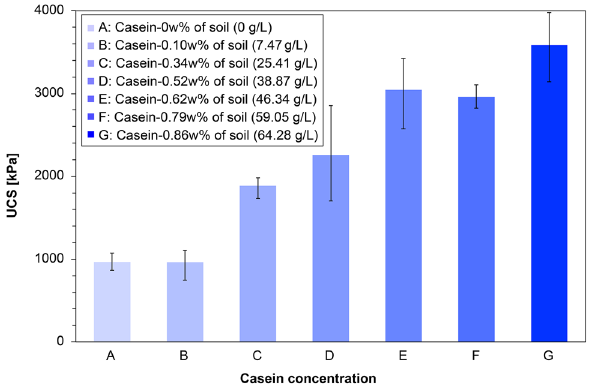
Figure 1. UCS results of specimens treated with varying casein contents and constant EICP-compound